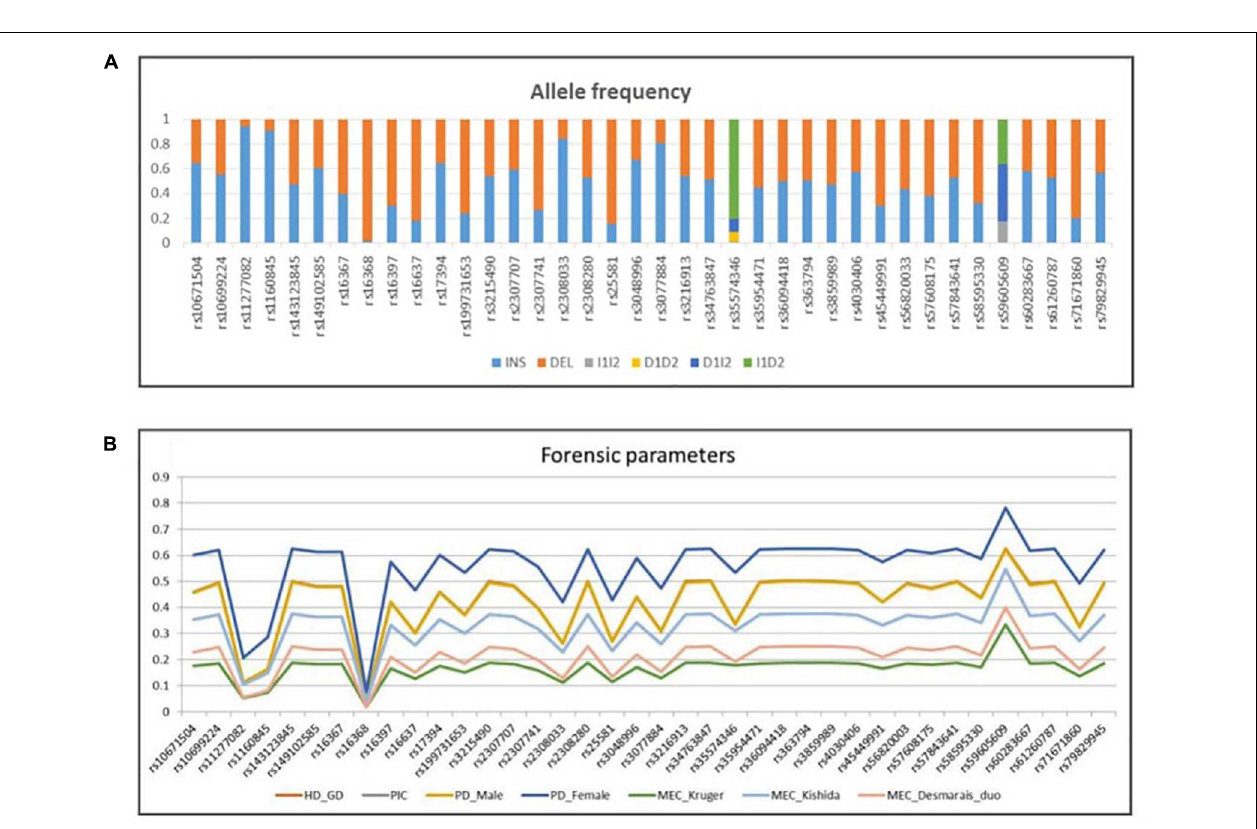
Frontiers in Genetics |